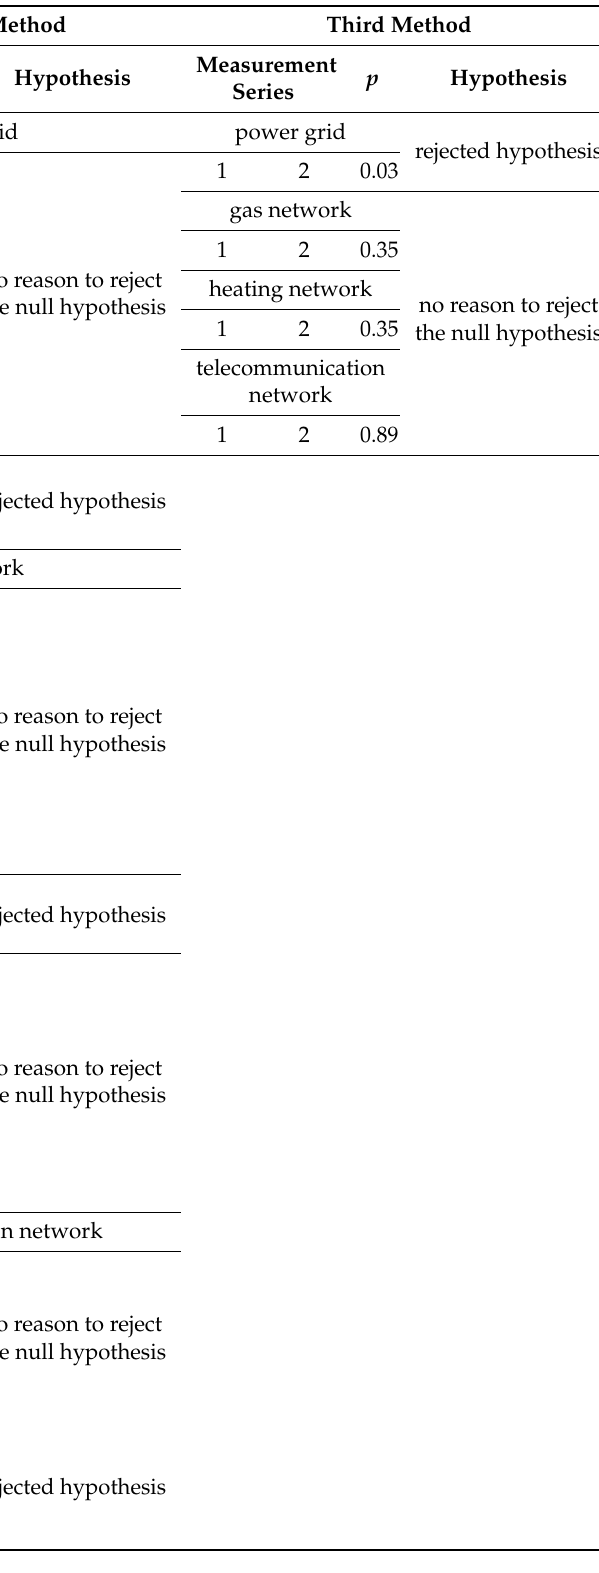
Table 6. Table showing the results of the